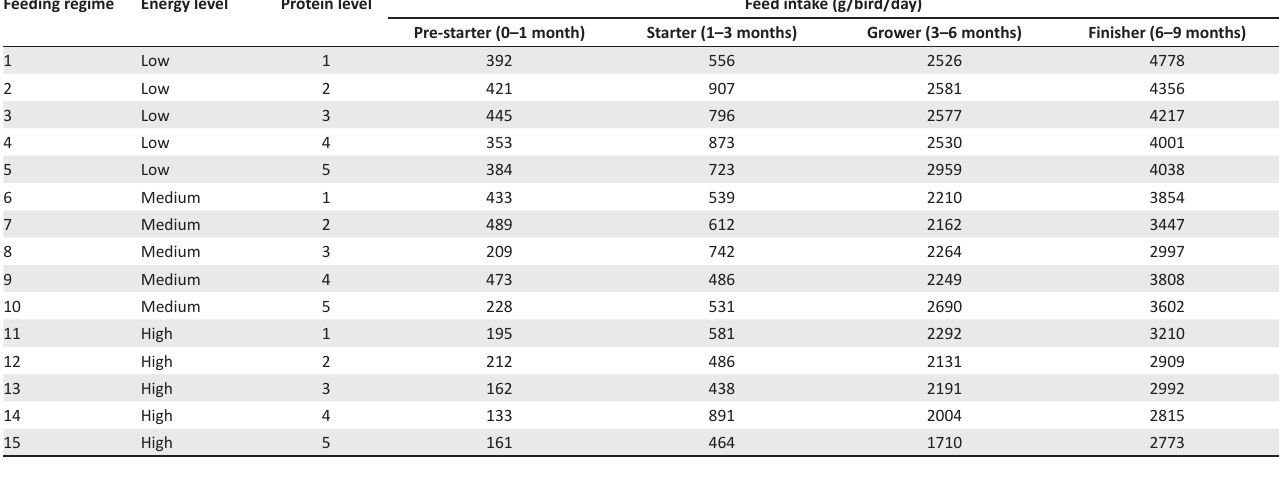
TABLE 3: Allometric coefficients relating the natural logarithm of muscle weight to the natural logarithm of empty body protein weight. Muscle (commercial name)